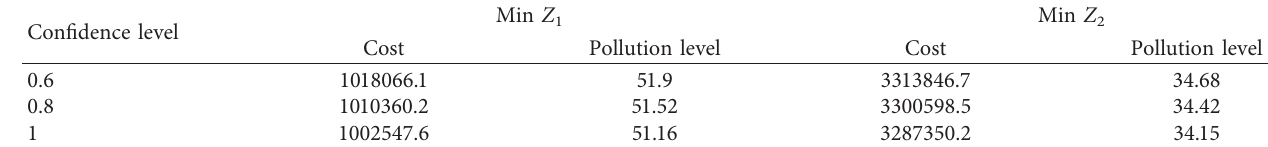
Table 5: Output of the second sample problem.